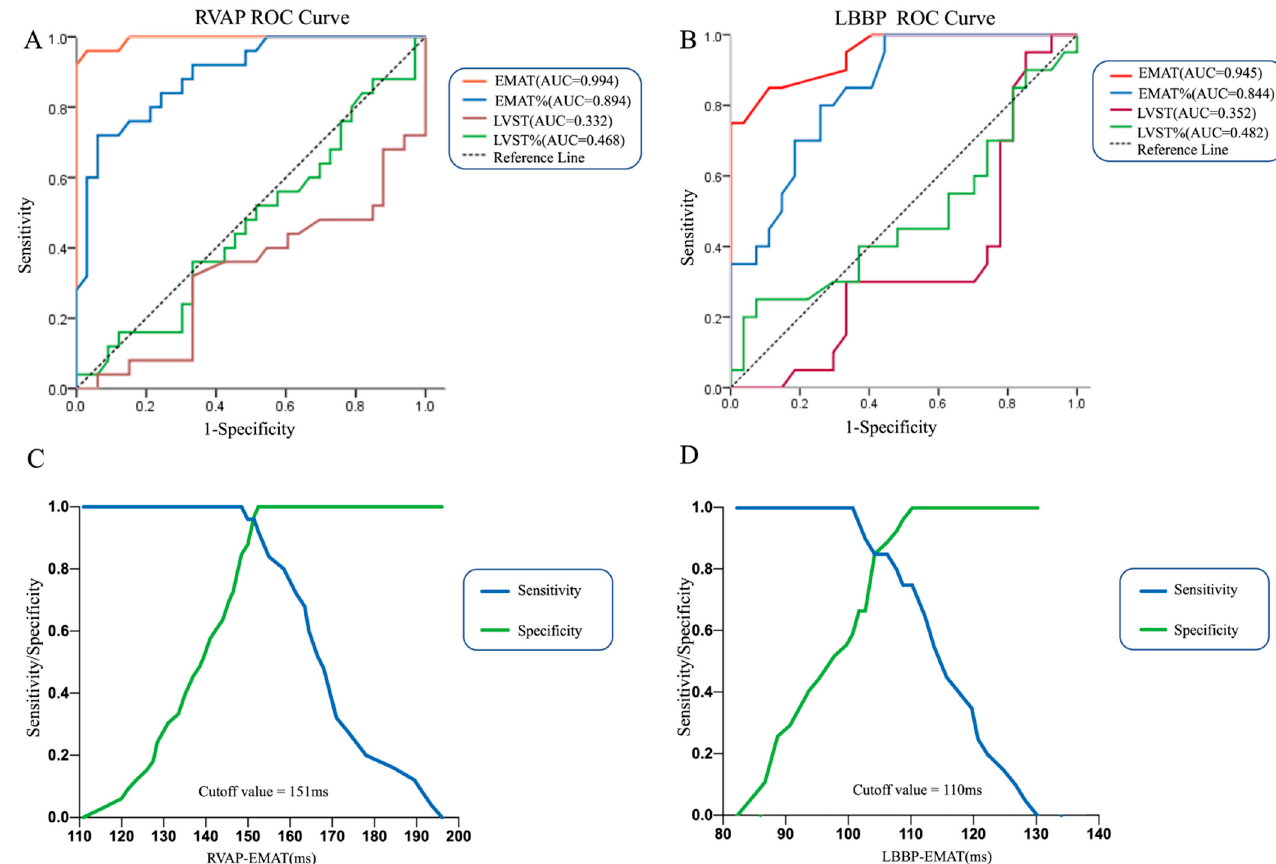
Figure 5. The diagnosis value of different cardiac acoustic biomarkers in LVSD. A and B, Comparison of EMAT, EMAT%, LVST and LVST % ROC analysis to identify LVSD in RVAP and LBBP groups. C and D, ROC analysis of EMAT for LVSD in RVAP and LBBP groups.